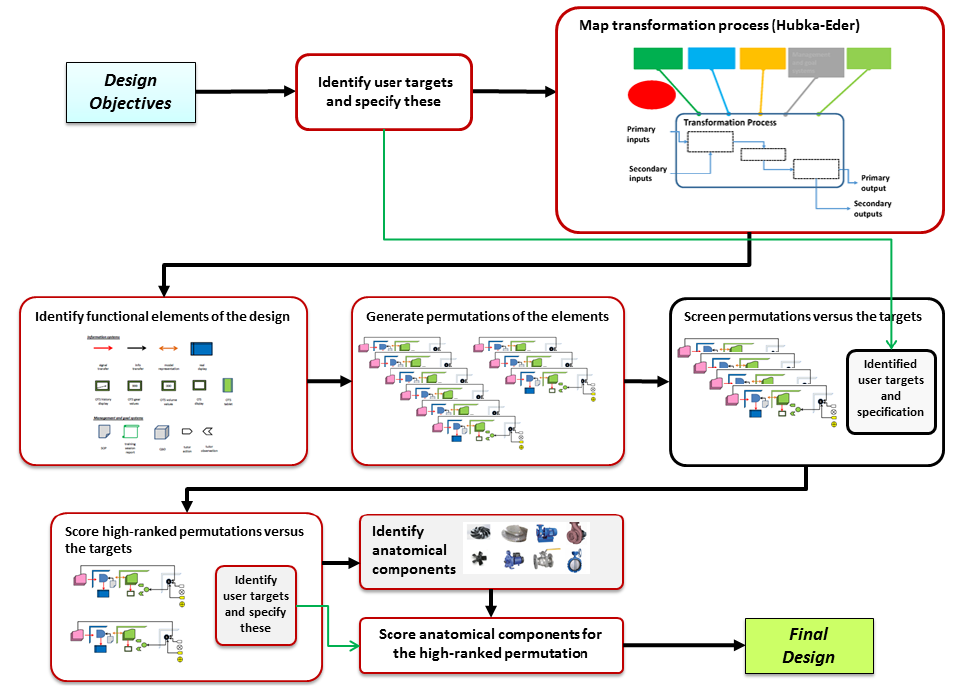
Figure 1. The generalized steps in the conceptual design methodology as applied to biotechnology products and systems (adapted from [22]). It should be underscored that the sequence of steps is iterative over extensive period of design